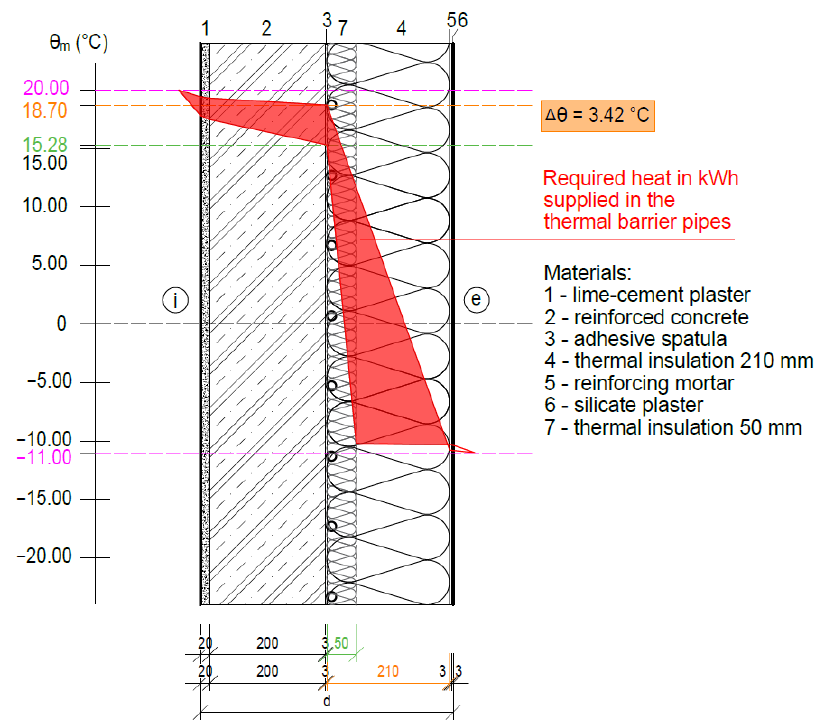
Figure 20. Required heat in kWh supplied by a heat transfer medium with a mean temperature of 18.7 °C to the ATP (function TB) using 50 mm thick static thermal insulation to achieve the standard thermal resistance. θ m —the temperature in construction (°C), Δθ —temperature di ff erence (°C), d— thermal resistance. θ m —the temperature in construction ( ◦ C), ∆ θ —temperature difference ( ◦ C), construction thickness (mm), e—exterior, and i—interior. d—construction thickness (mm), e—exterior, and